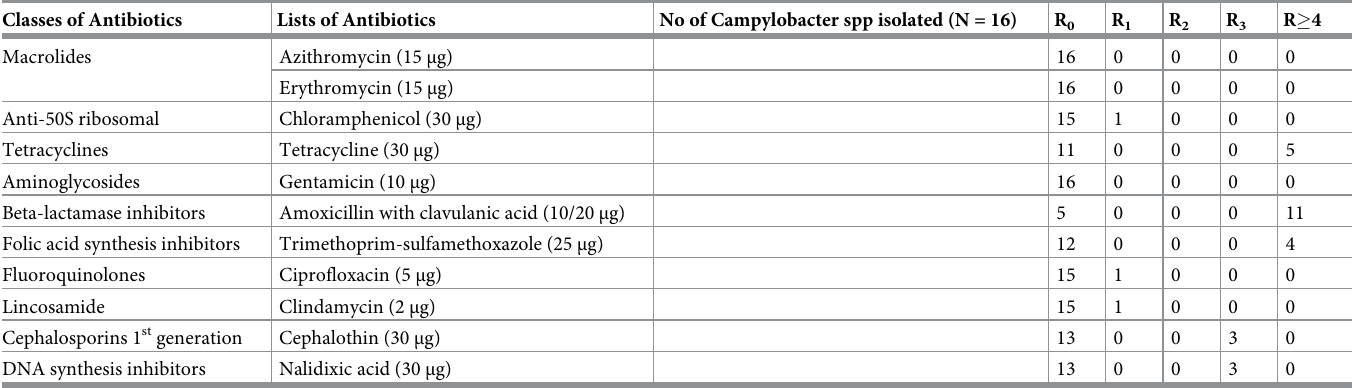
Table 6. Multiple drug resistance patterns of Campylobacter isolates in under five diarrhoeic children at Governmental Hospitals in Hawassa city, Sidama,